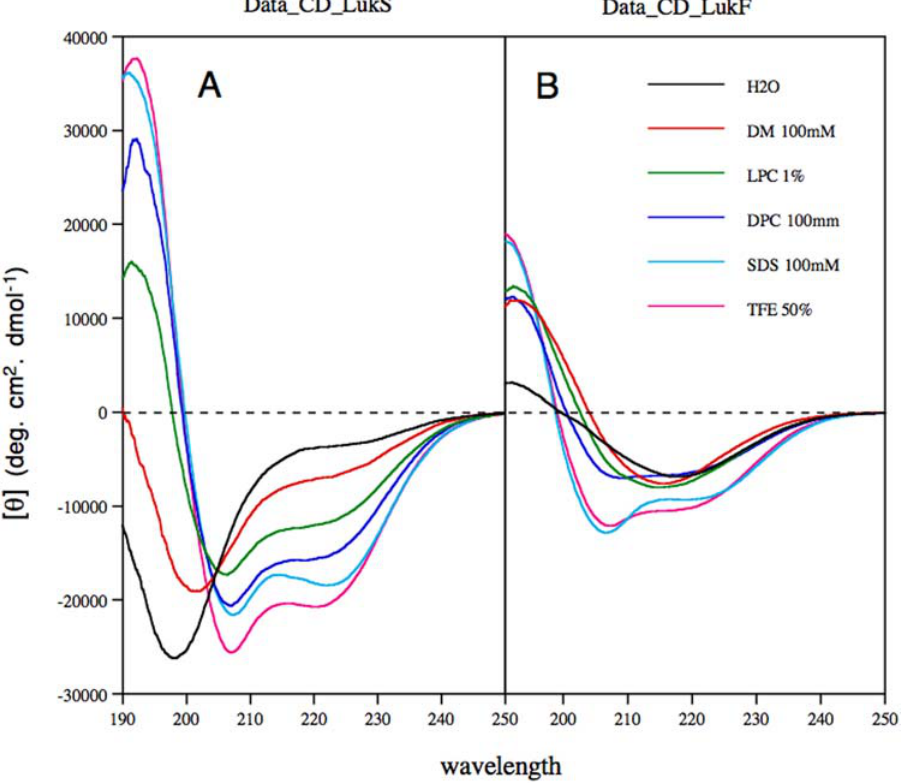
Figure 11. Far-UV circular dichroism (CD) analyses of synthetic peptides LukS-PV SP (A) and LukF-PV SP (B) in various environments. CD spectra were recorded in water (H 2 O), complemented with either 50% 2,2,2-trifluoroethanol (TFE) or 1% L- a -lysophosphatidyl choline (LPC), or the following detergents: 100 mM sodium dodecyl sulfate (SDS), 100 mM n-dodecyl- b -D-maltoside (DM), or 100 mM dodecyl phosphocholine